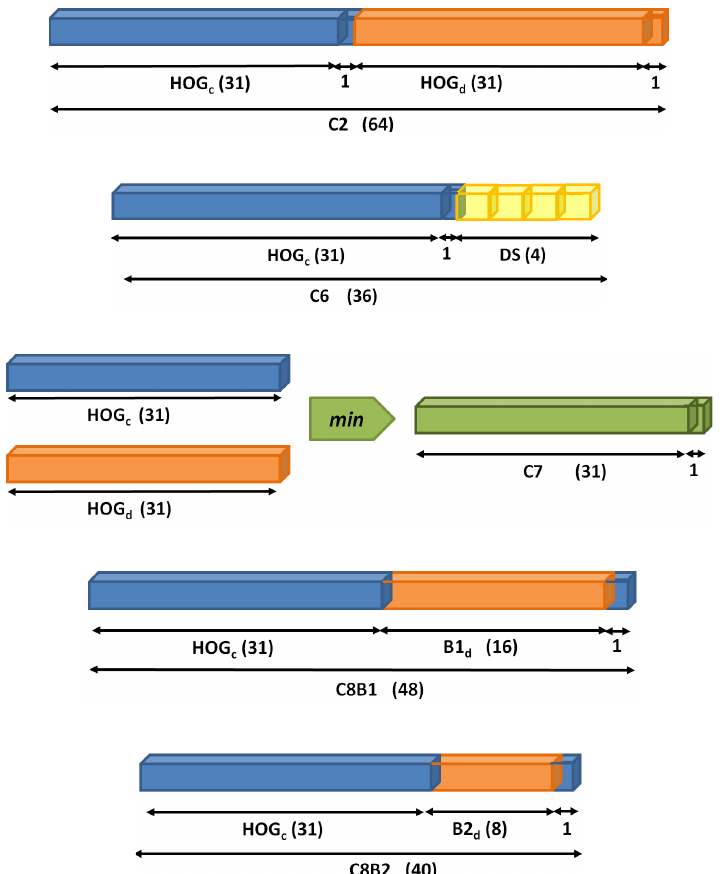
Figure 6. 3D-aware features based on HOG and computed from 2.5D data. Subindex c refers to color and d to